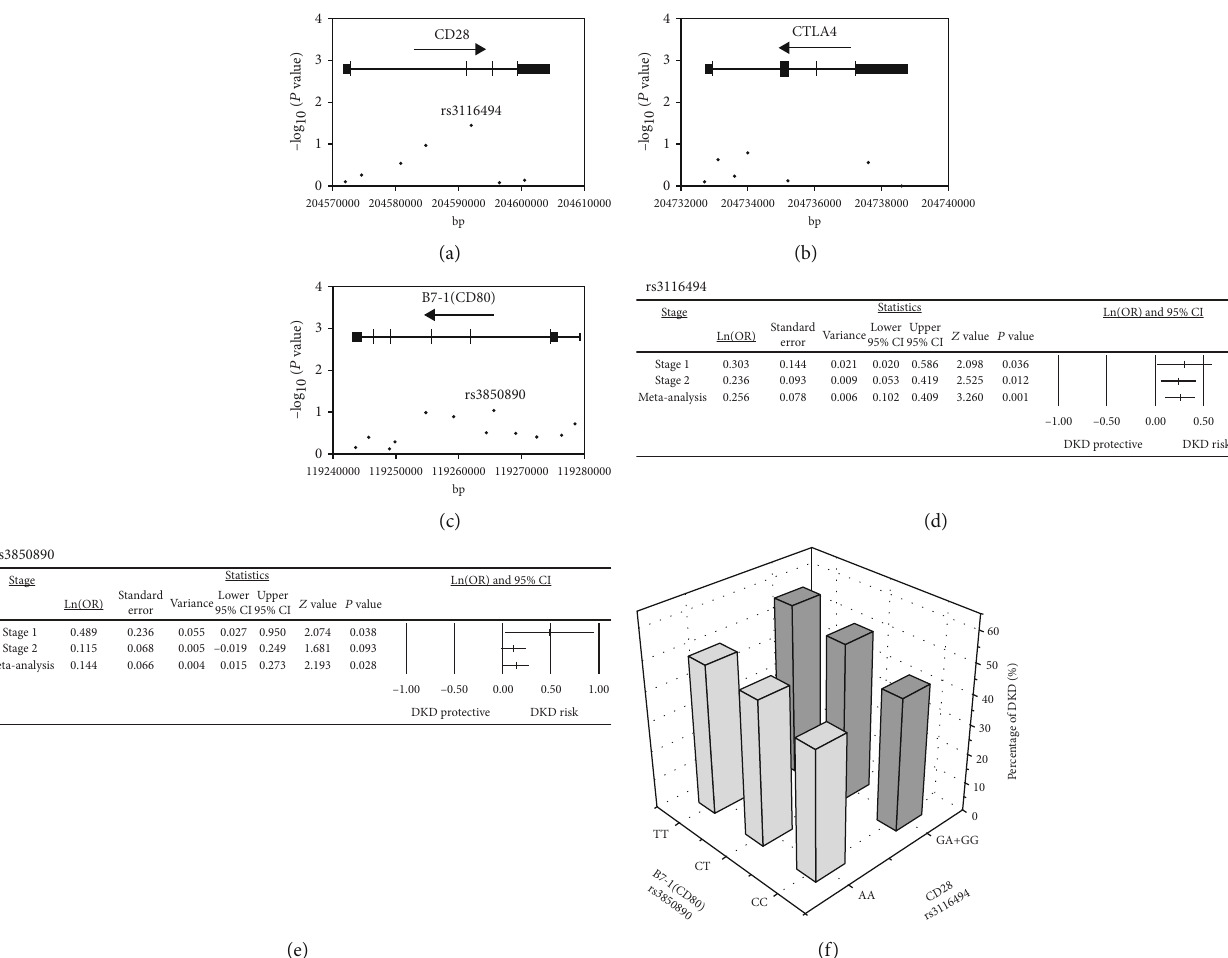
Figure 1: Genetic association analysis between CD28 , CTLA4 , and CD80 variants with DKD in the study population. Summary of association analyses for single-nucleotide polymorphisms (SNPs) in (a) CD28 (7 SNPs), (b) CTLA4 (7 SNPs), and (c) CD80 (12 SNPs) gene regions with DKD. Meta-analysis of the two study stages for association of DKD with (d) CD28 -rs3116494 and (e) CD80 -rs3850890. Data were natural log- transformed and show odds ratio (point), standard error, variance, lower 95% con fi dence interval, and upper 95% con fi dence interval. (f) Interaction analysis for CD28 -rs3116494 and CD80 -rs3850890 in the study population; the 2 SNPs were interactive ( P < 0 : 01 ). The percentage of patients with DKD based on the genotypes for CD28 -rs3116494 and CD80 -rs3850890 is shown. Table 2: Association between validated SNPs and DKD-related traits in study participants.